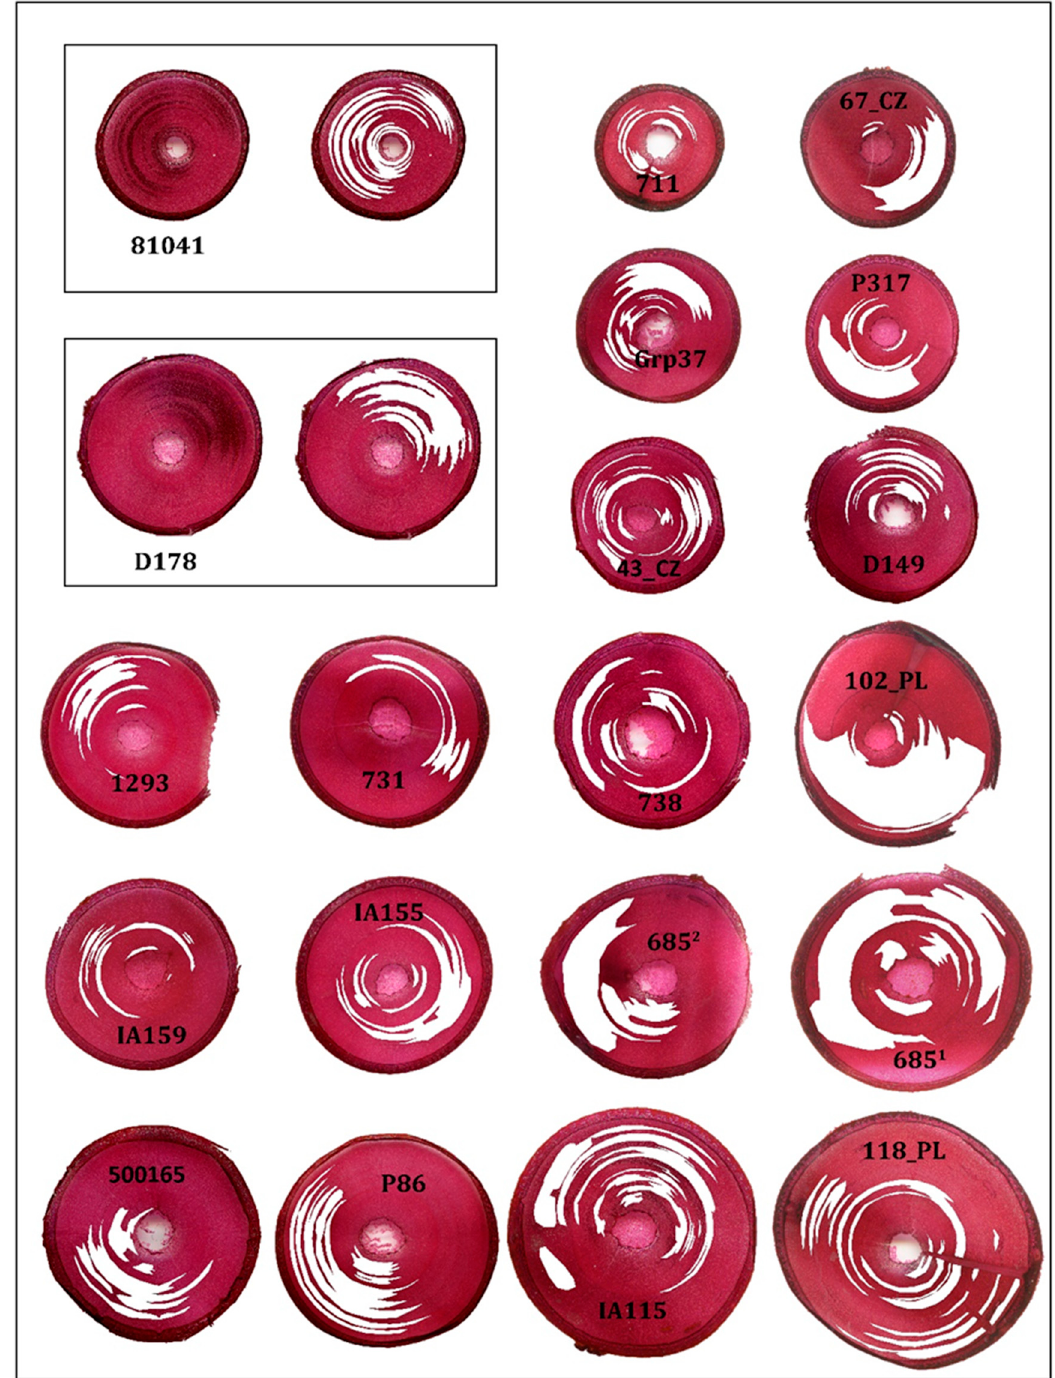
Figure 3. Images of S. viminalis stem basal cross-sections after double staining with chlorazol black E and safranin. Inset shows two clones with areas of tension wood before and after marking the tension wood using photoshop. The remainder of the figure shows selected clones with areas of tension wood marked only. Note that the tension wood shows variable multilateral and unilateral development in the growth rings of the two-year stems.